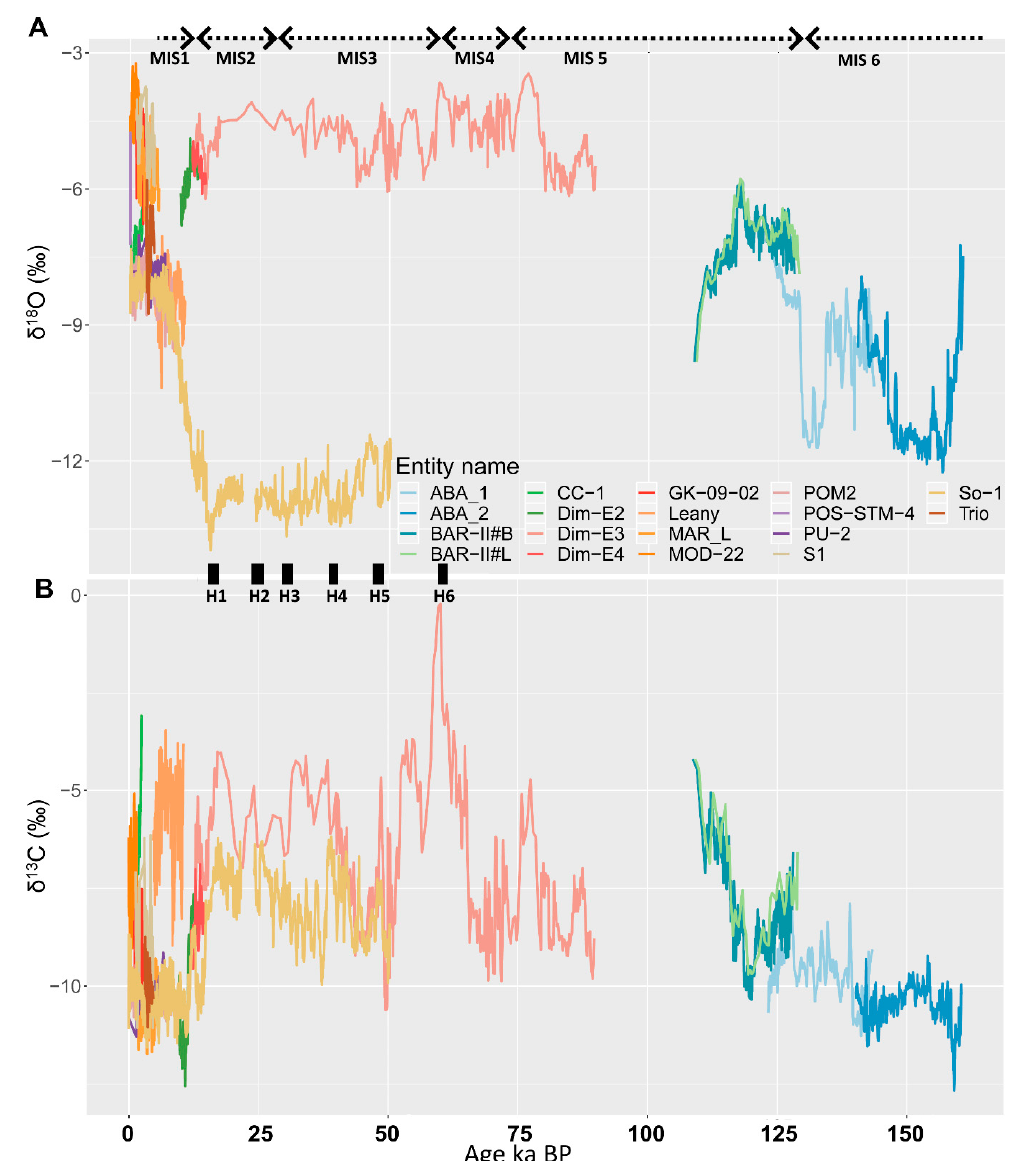
Figure 2. Timeseries of individual speleothem records from the Eastern part of Europe and Turkey for ( A ) δ 18 O and ( B ) δ 13 C during the last 160 kyrs. Marine Isotope Stages (MIS [82]) are indicated by dashed horizontal arrows. Durations of Heinrich events (e.g., H1 [83]) are shown with black boxes between panels ( A , B ).